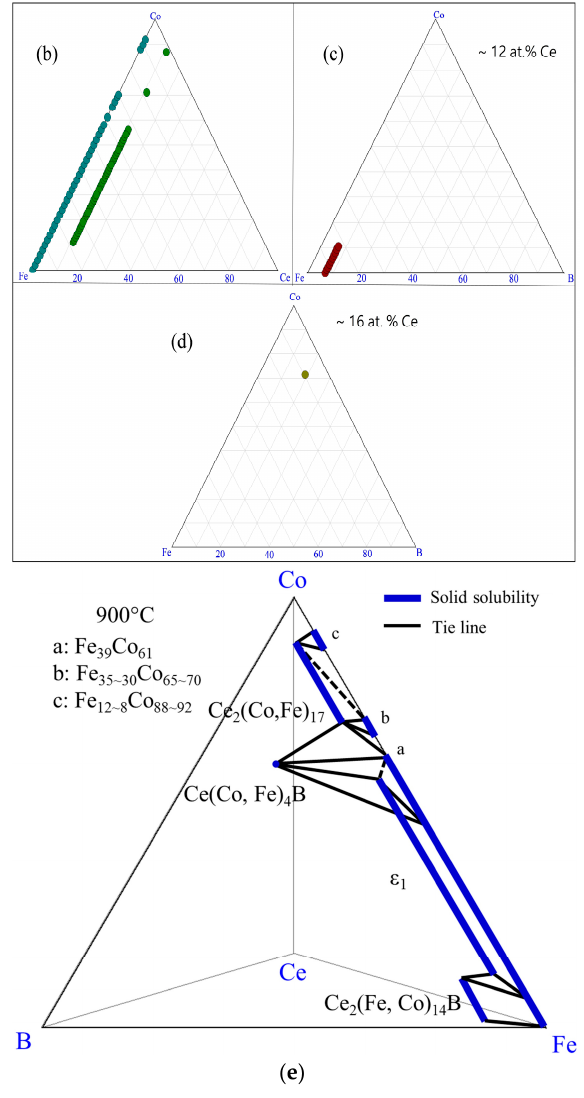
Figure 6. The results of the diffusion couple 1 at 900 °C: ( a ) 3D presentation of the experimental results; ( b ) Fe-Ce-Co ternary system; ( c ) pseudo ternary section at ~12 at. % Ce; ( d ) pseudo ternary section at ~16 at. % Ce; ( e ) phase relations obtained from DC1.